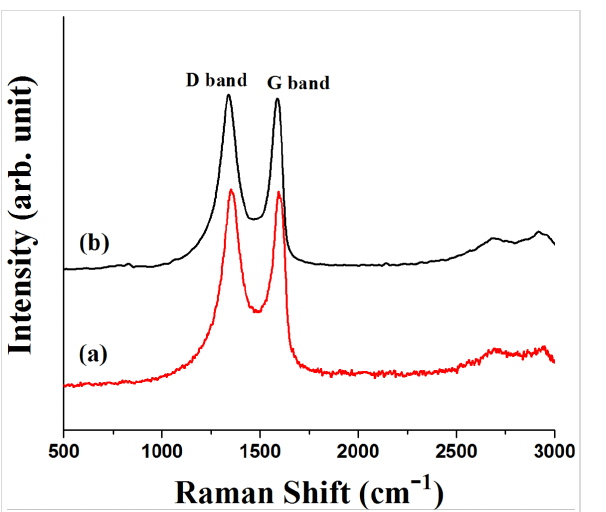
Figure 2: (a) Raman spectrum of fresh Ni/RGO-40 and (b) recovered catalyst after the first cycle of C–S coupling.